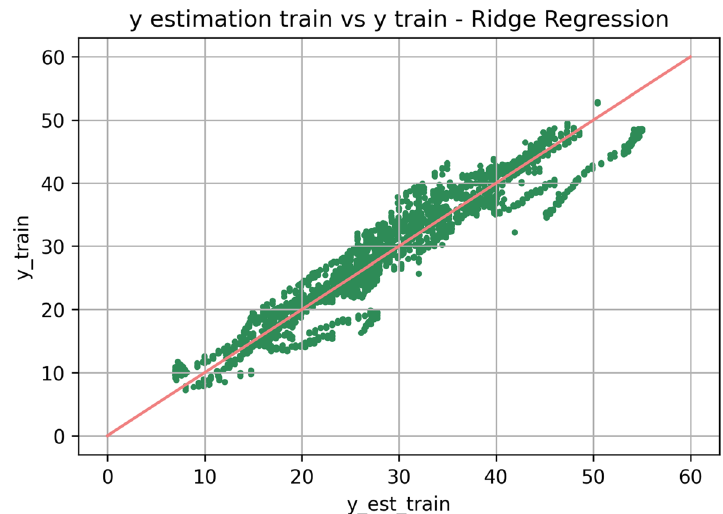
Fig. 18 y estimation train vs y train